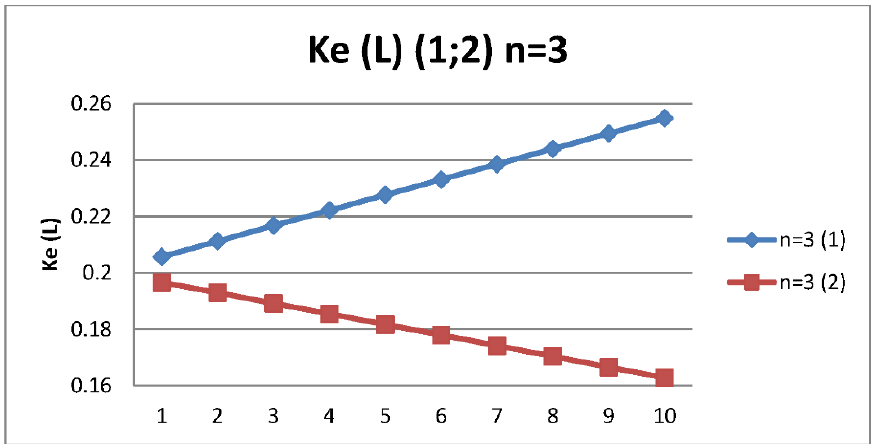
Figure 3. Dependence of the equity cost, k e , on leverage level L in the cases of payments of tax on profit at the end of the year (1) and in the beginning of the year (2) for three-year company.